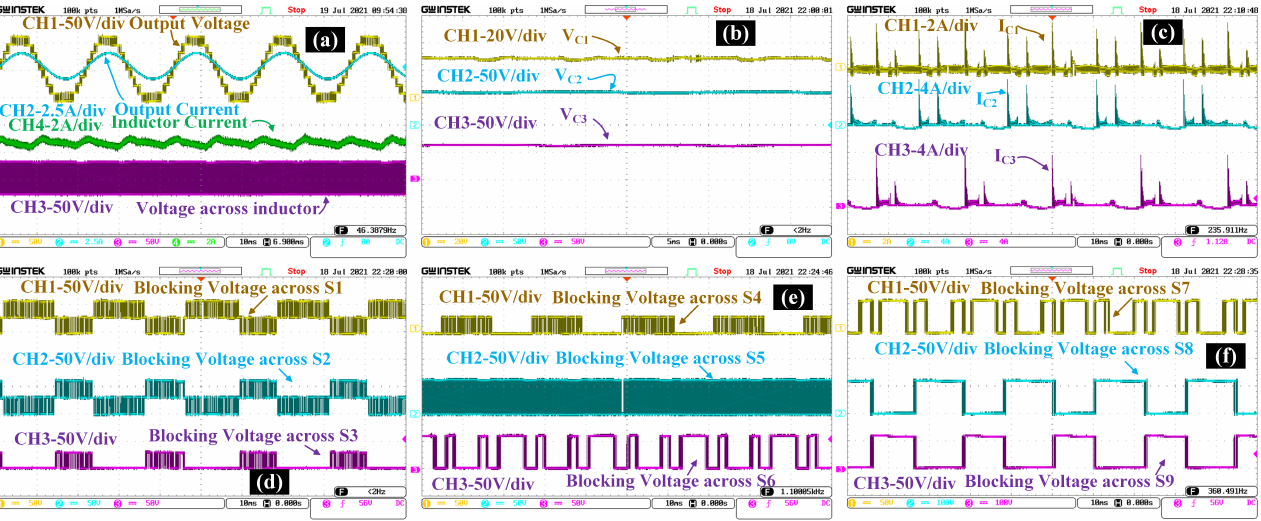
Figure 7. Experimental Results for load 50 Ω , 20 mH at V in = 30 V . ( a ) Output voltage and Output current, ( b ) Voltage across capacitor ( V C 1 , V C 2 , V C 3 ), ( c ) Capacitor current profile ( I C 1 , I C 2 , I C 3 ), ( d ) Blocking Voltage across S 1 to S 3 , ( e ) Blocking Voltage across S 4 to S 6 , ( f ) Blocking Voltage across